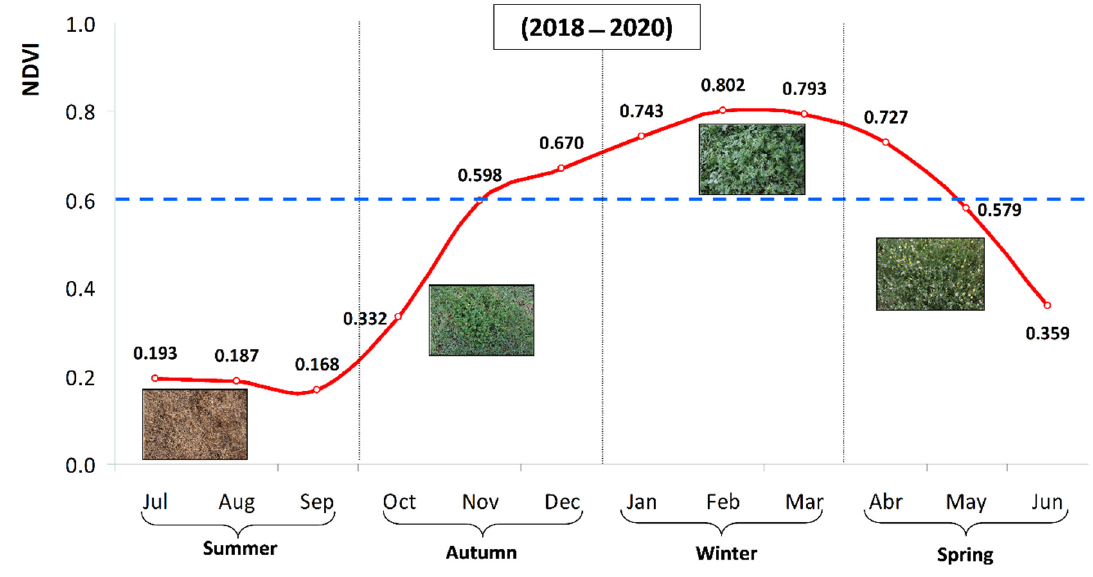
Figure 7. Evolution of monthly mean normalized difference vegetation index (NDVI) at the experimental field during pasture vegetative cycles of 2018/2019 and 2019/2020. The broken line (NDVI = 0.6) correspond to the sheep CP maintenance requirements [27].